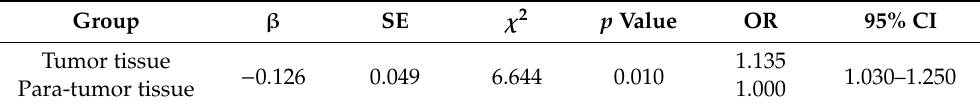
Table 2. Conditional logistic regression analysis of the risk for esophageal cancer of miR-21-3p. Group β SE χ 2 p Value OR 95% CI Tumor tissue − 0.126 0.049 6.644